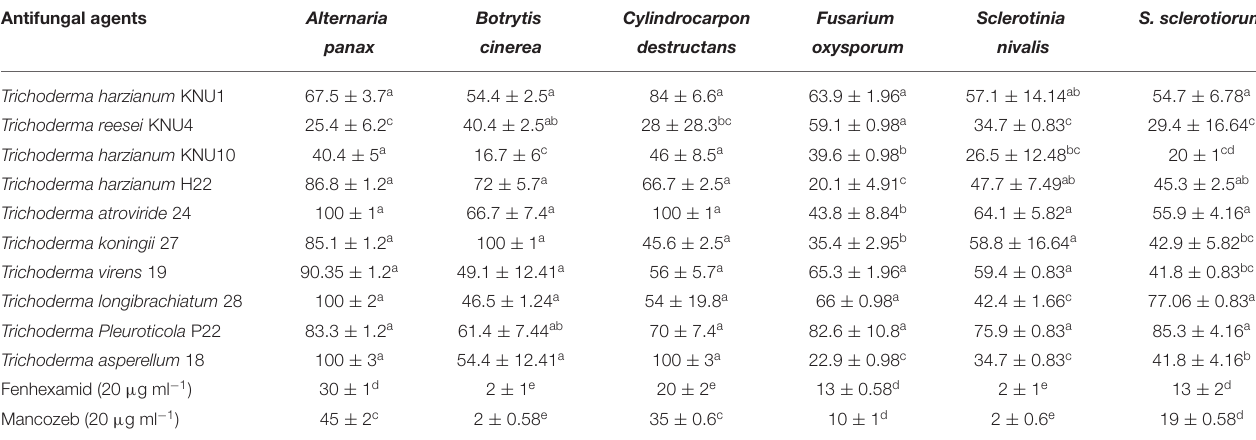
TABLE 3 | The antifungal effect of Trichoderma spp. and chemical fungicide against the phytopathogenic fungi.